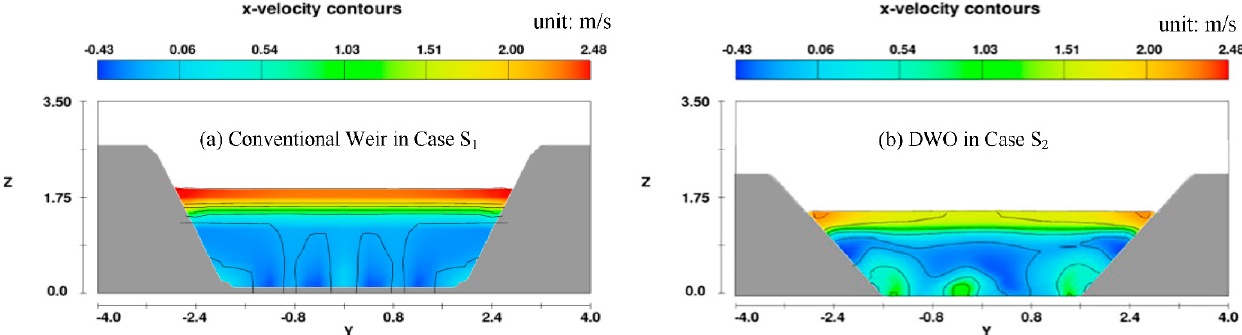
Figure 12. Velocity contours of the cross-section ( X/L = 0.41, middle stream) for the conventional weir of Case S 1 and the DWO of Case S 2 in panel ( a , b ). The velocity is larger, up to 2.5 m/s, because the circumfluence is concentrated at the weir top in S 1 , but the velocity at the weir top in S 2 is only about 1.2 to 1.5 m/s. The velocity profile in the cross-section is more uniform than that in S 1 and also more suitable for fish migration. The meanings of all the variables and symbols in the figure are the same as above.